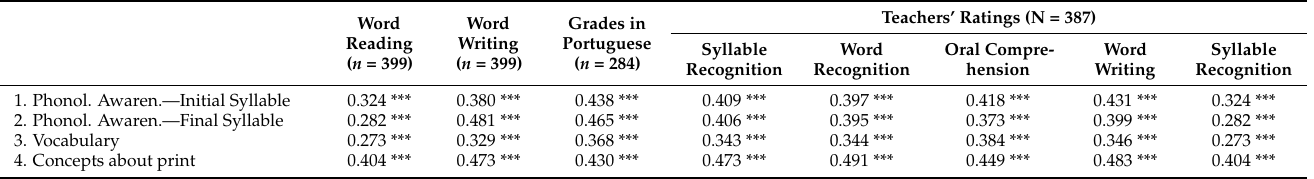
Table 7. Correlations between screening test scores and reading, writing, school achievement, and teachers’ rating for the first-grade